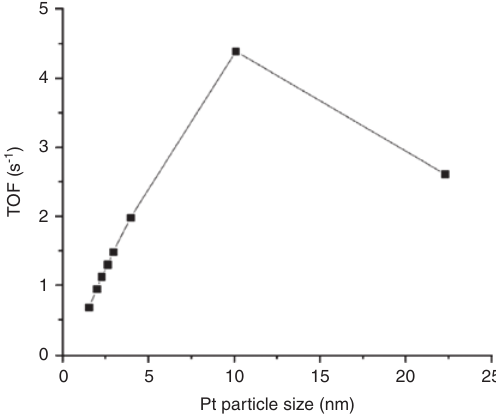
Figure 8: TOFs as a function of Pt particle size (calculated from CO chemisorption). Reproduced from [35] with permission from Elsevier BV.